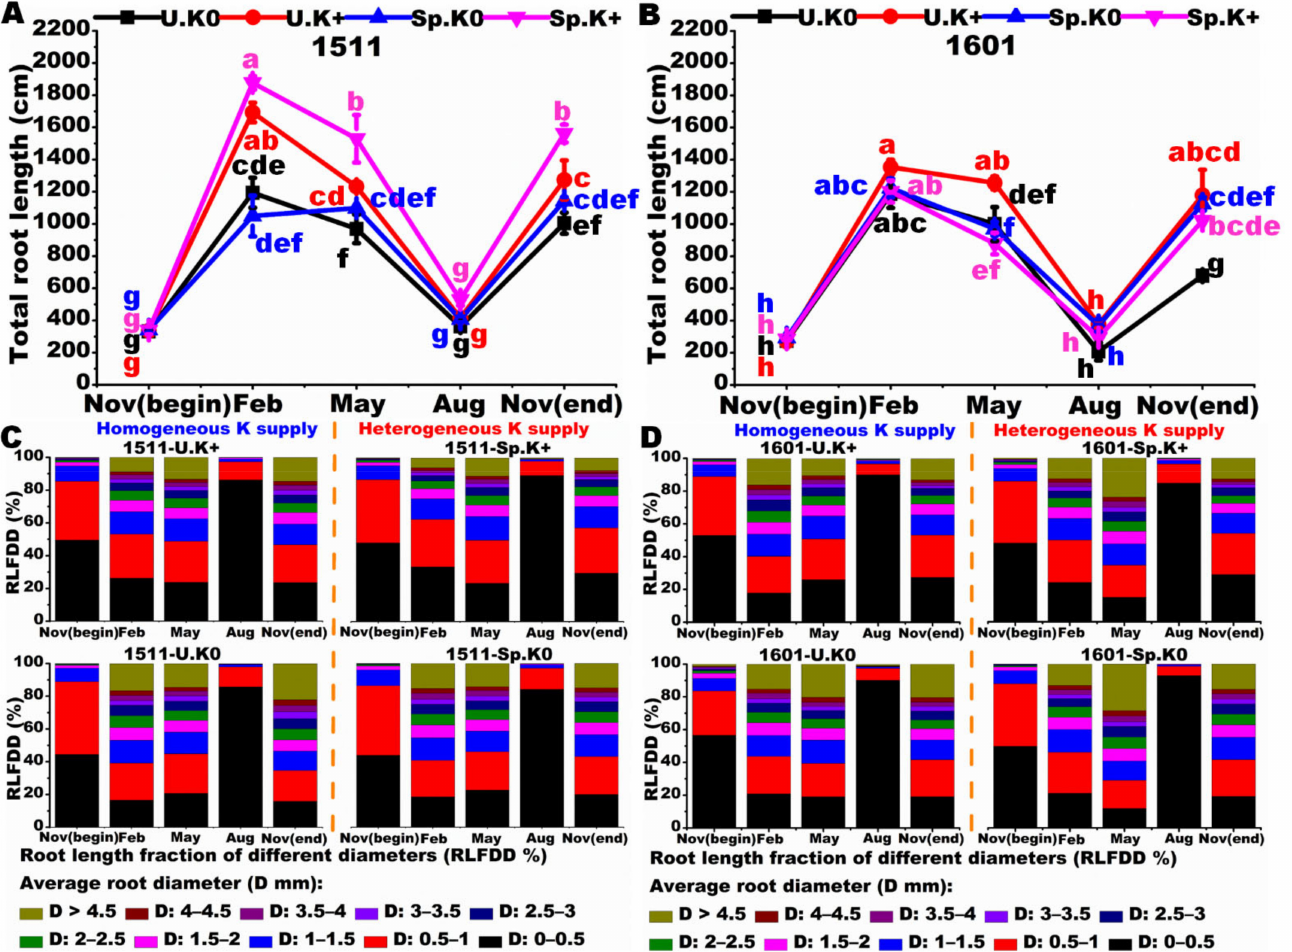
Figure 5. Temporal variations of total root length and root length fractions of tea plants. Temporal variation of total root length of genotype “1511” ( A ). Temporal variation of total root length of genotype “1601” ( B ). Root length fraction changes of each diameter of genotype “1511” ( C ). Root length fraction changes of each diameter of genotype “1601” ( D ). The letter colors were consistent with the representative colors of the treatments. Different letters represent significant differences at the level of p < 0.05. Data are means ± SE ( n =